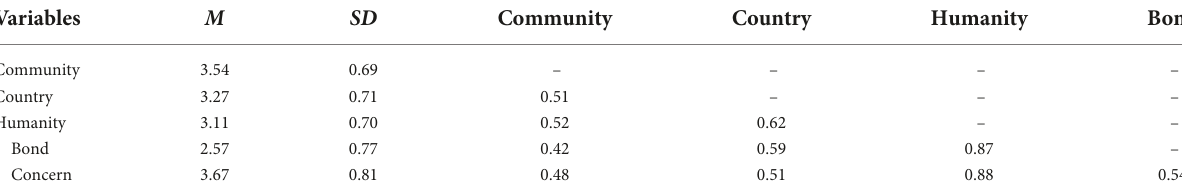
TABLE 1 Means, standard deviations and correlations among IWAH scale’s dimensions and subscales in the total sample. Variables M SD Community Country Humanity